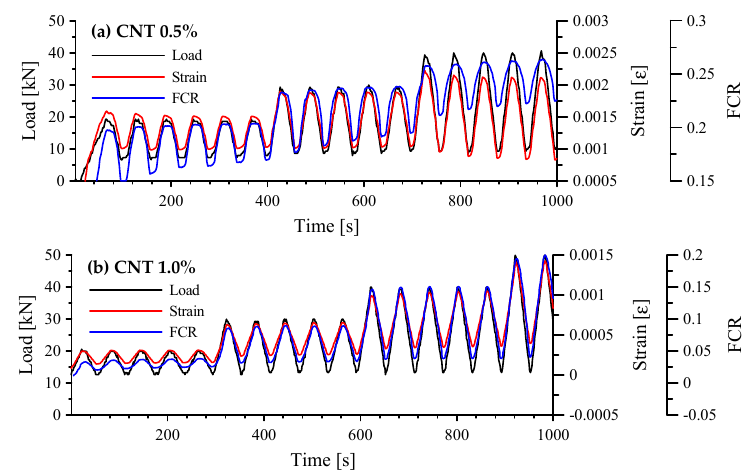
Figure 11. Responses of cement-based composites with 0.5 and 1.0 vol.% MWCNTs under cyclic